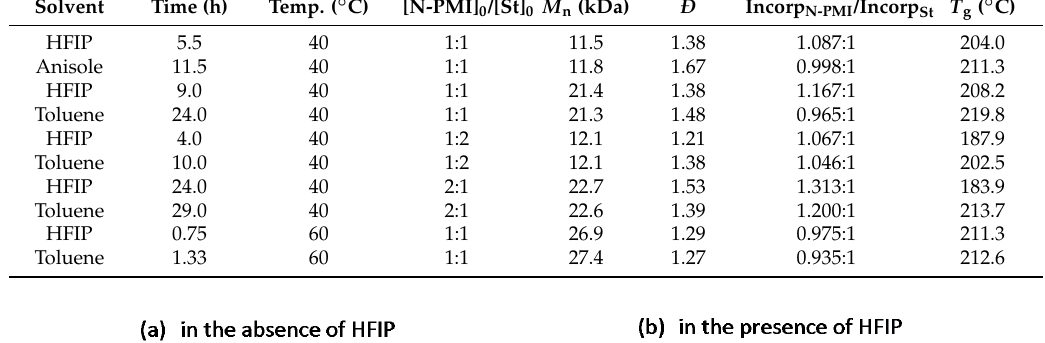
Table 2. Glass transition temperature of N-PMI/St copolymers obtained with different solvents. Solvent